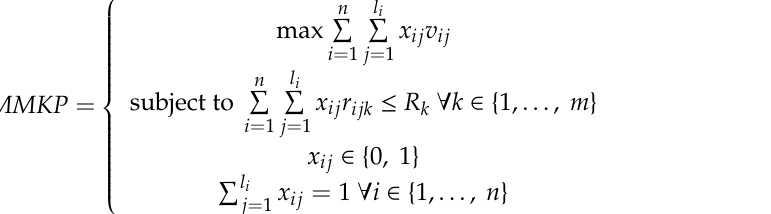
Figure 1. Description of a system composed of multiple subsystems and multiple options for each subsystem.